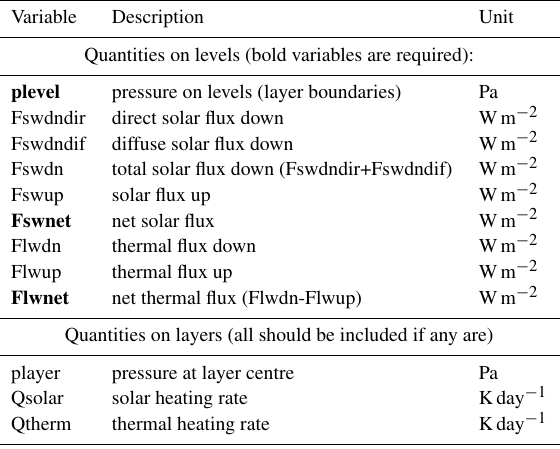
Table 2. Model output that will be accepted by PALAEOTRIP.